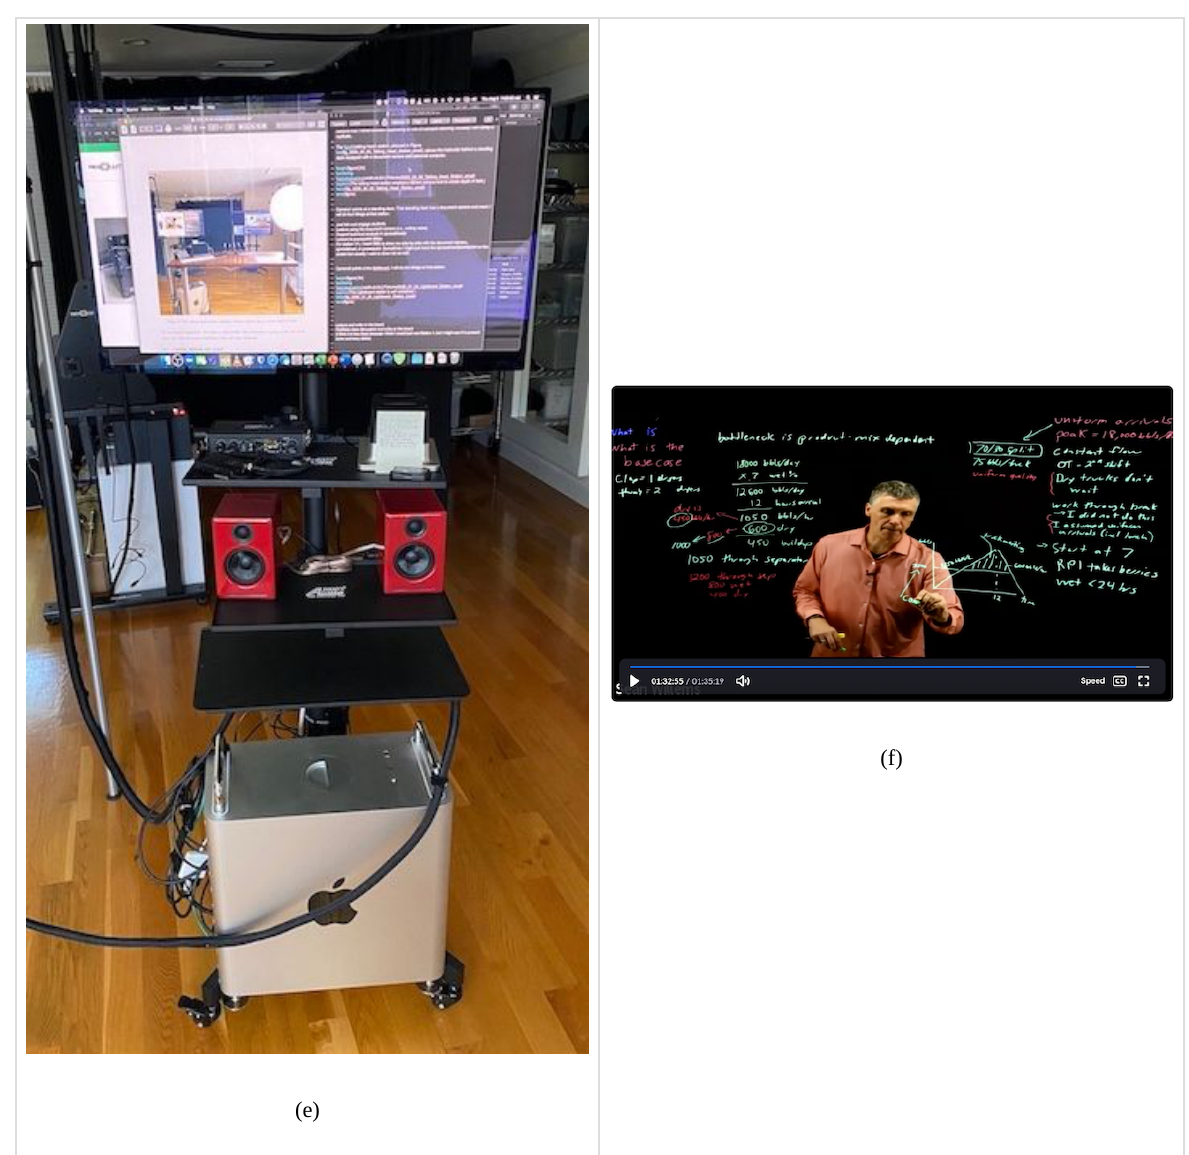
Figure 9. Online teaching home studios for: Andrew Lo (a and b); Brian Stevens (c); and Sean Willems